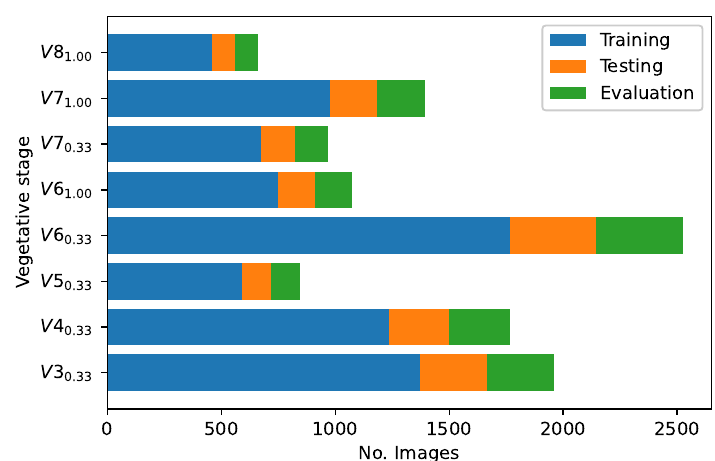
Figure 3. Distribution of the database according to vegetative stage and GSD.